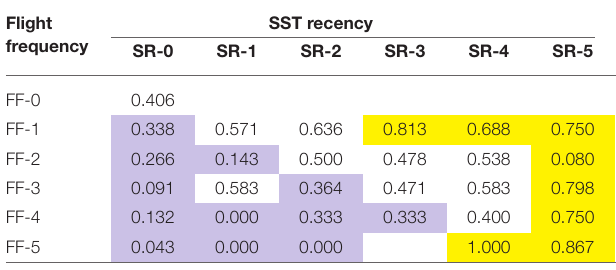
TABLE 3 | Distribution of SST usage